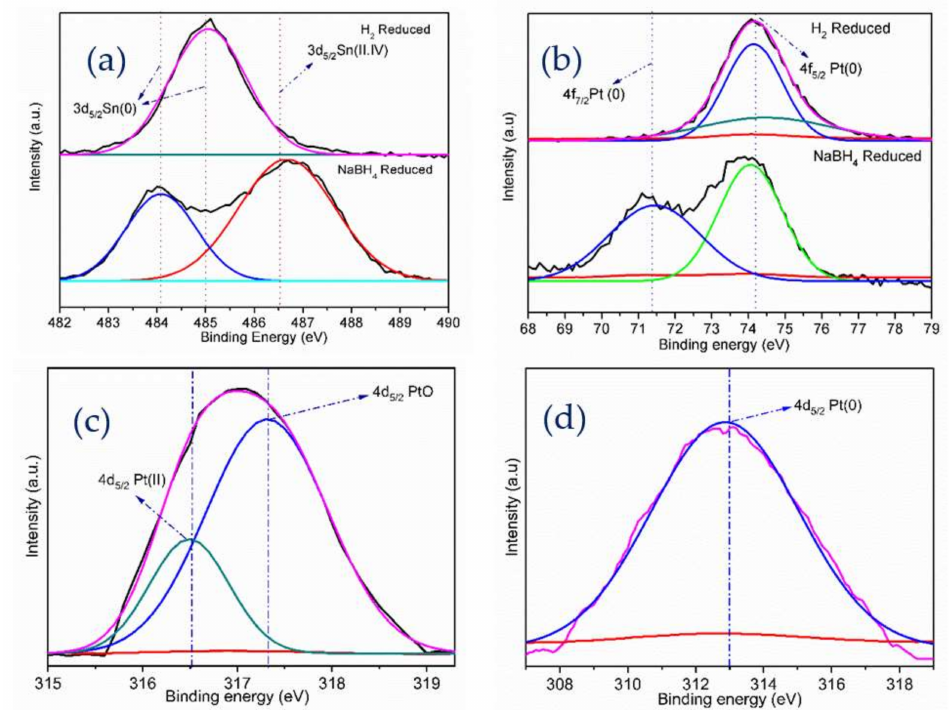
Figure 4. XPS spectra for the Pt–Sn–Al 2 O 3 catalyst ( a ) Sn 3d, ( b ) Pt 4f, and ( c ) Pt 4d of the NaBH 4 reduced catalyst; and ( d ) Pt 4d of the H 2 reduced